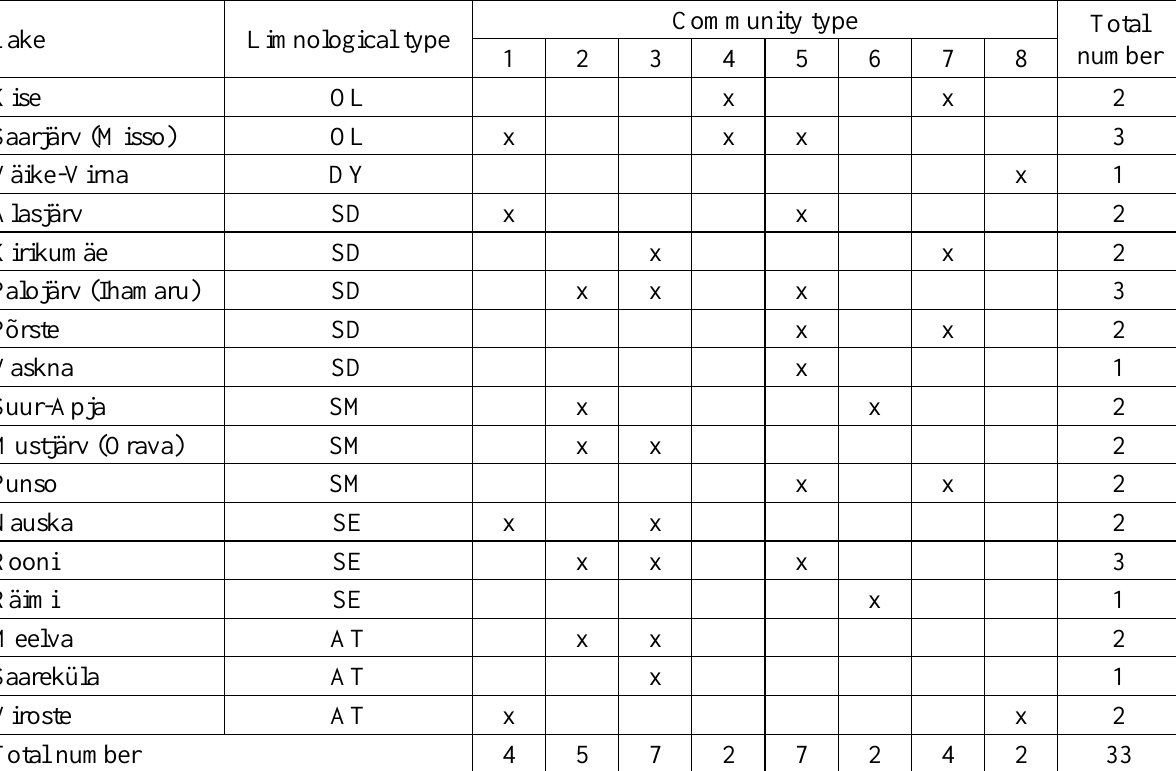
Table 11. Distribution of plant communities in quagmires around the studied lakes. Notation for limnological types as in Table